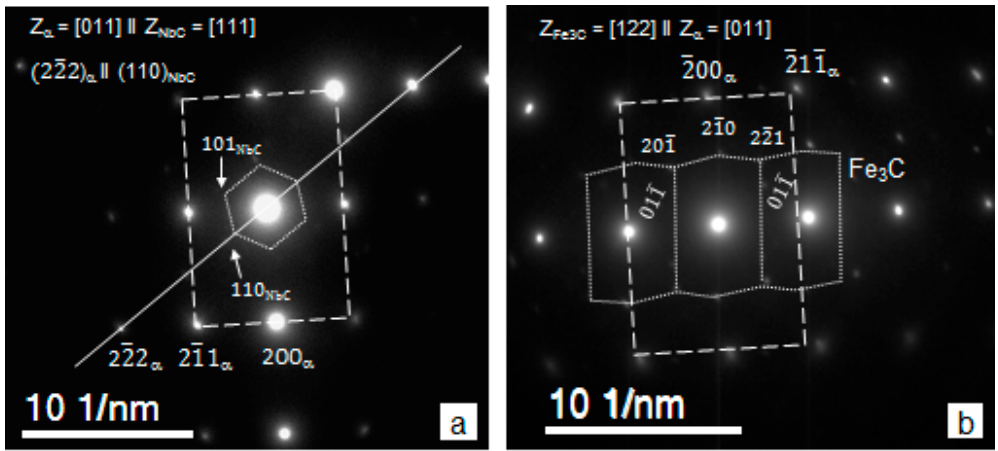
Figure 8. Determination of NbC and Fe 3 C using TEM diffraction patterns.